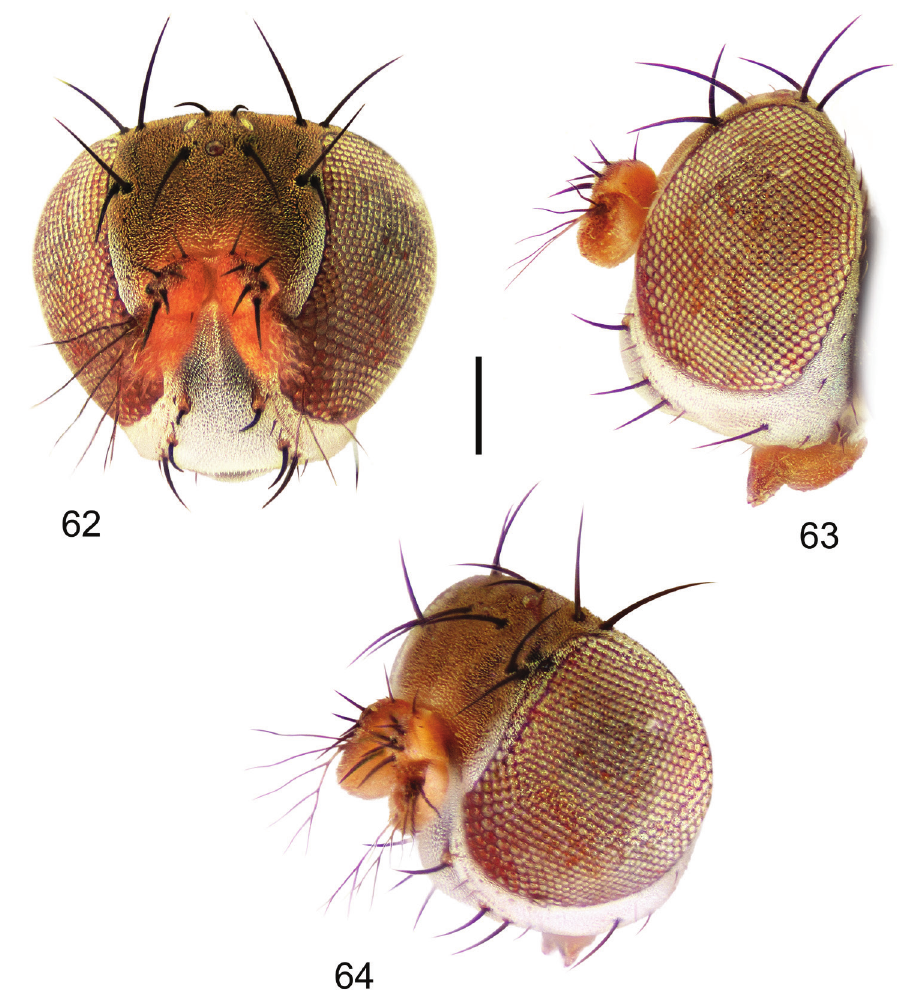
Figures 62–64. Hydrochasma denticum sp. n. (Ecuador. Orellana: Río Tiputini) 62 head, anterior view 63 same, lateral view 64 same, oblique view. Scale bar = 0.1 dark gray; parafacial silvery white, concolorous with facial coloration (Figs 62–64); gena-to-eye ratio 0.0.19–0.21. Thorax: Wing with costal vein ratio 0.68–0.71; M vein ratio 0.54–0.56. Forecoxa whitish gray, yellowish at apices; forefemur lacking a dis- tinctive, comb-like row of stout setulae along anteroventral surface; tibiae mostly gray. Abdomen: Tergites 2–3with wedge-shaped silvery-gray areas on slate black dorsum (Fig. 71); tergite 5 of male mostly gray with blackish posterior margin. Male termi- nalia (Figs 65–68): Combined structures generally moderately elongate, in posterior view height 2.25× width, generally sparsely setulose dorsally, setulae sparse or lacking ventrally; epandrium lacking dorsal arch above cerci, in posterior view (Fig. 65) with